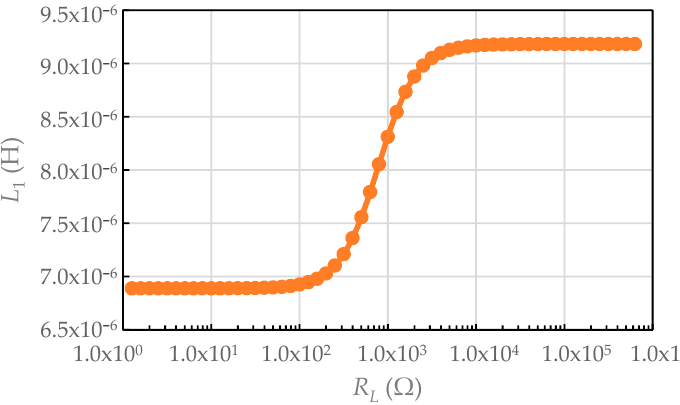
Figure 10. Inductor value L 1 at various load resistances R L .